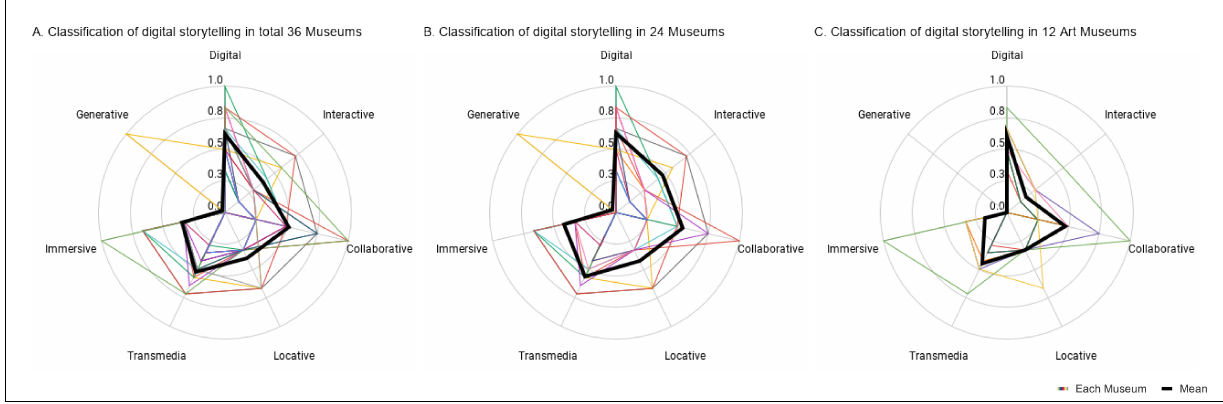
Figure 4. The radar plot shows which type of storytelling is using in the guide applications in 36 museums. A-total 36 guide applications from museums and art museums(B+C); B-24 guide applications of museums; C-12 guide applications of art museums. The Bold Black line shows the mean of all data, and the colored lines show each